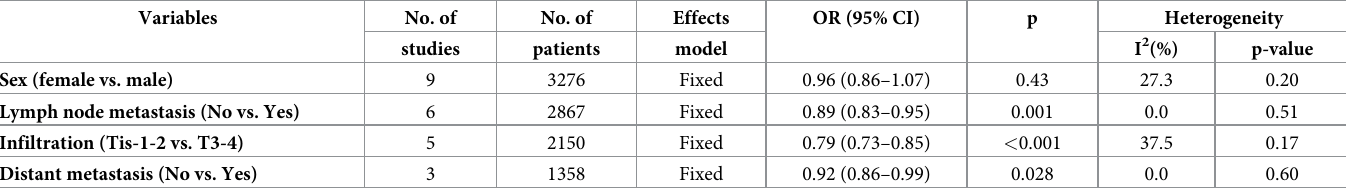
Table 3. Results of the meta-analysis of clinicopathological characteristics. Variables No. of No. of Effects OR (95% CI) p Heterogeneity studies patients model I 2 (%)